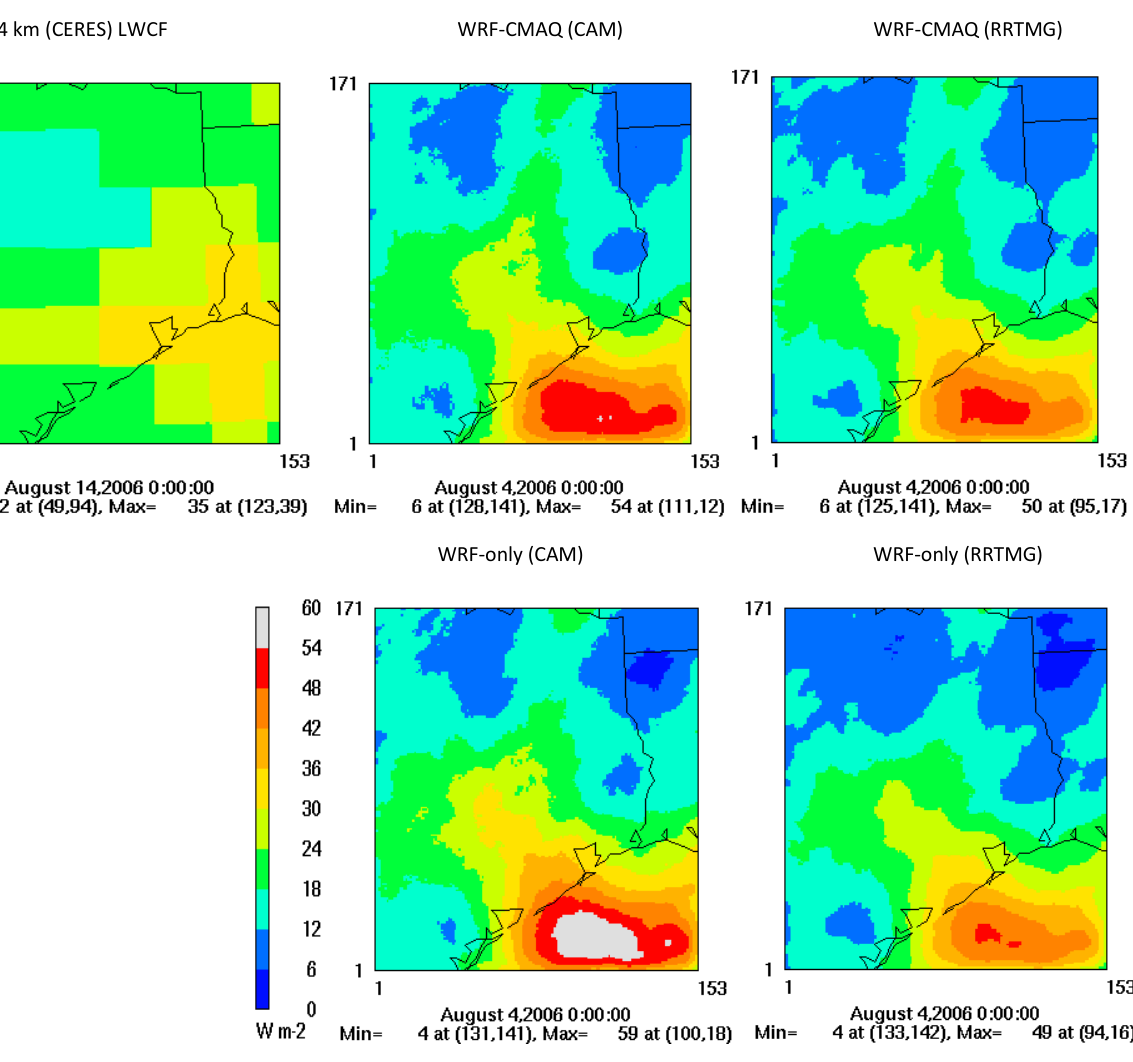
Figure 14. Same as Figure 10 but for LWCF.